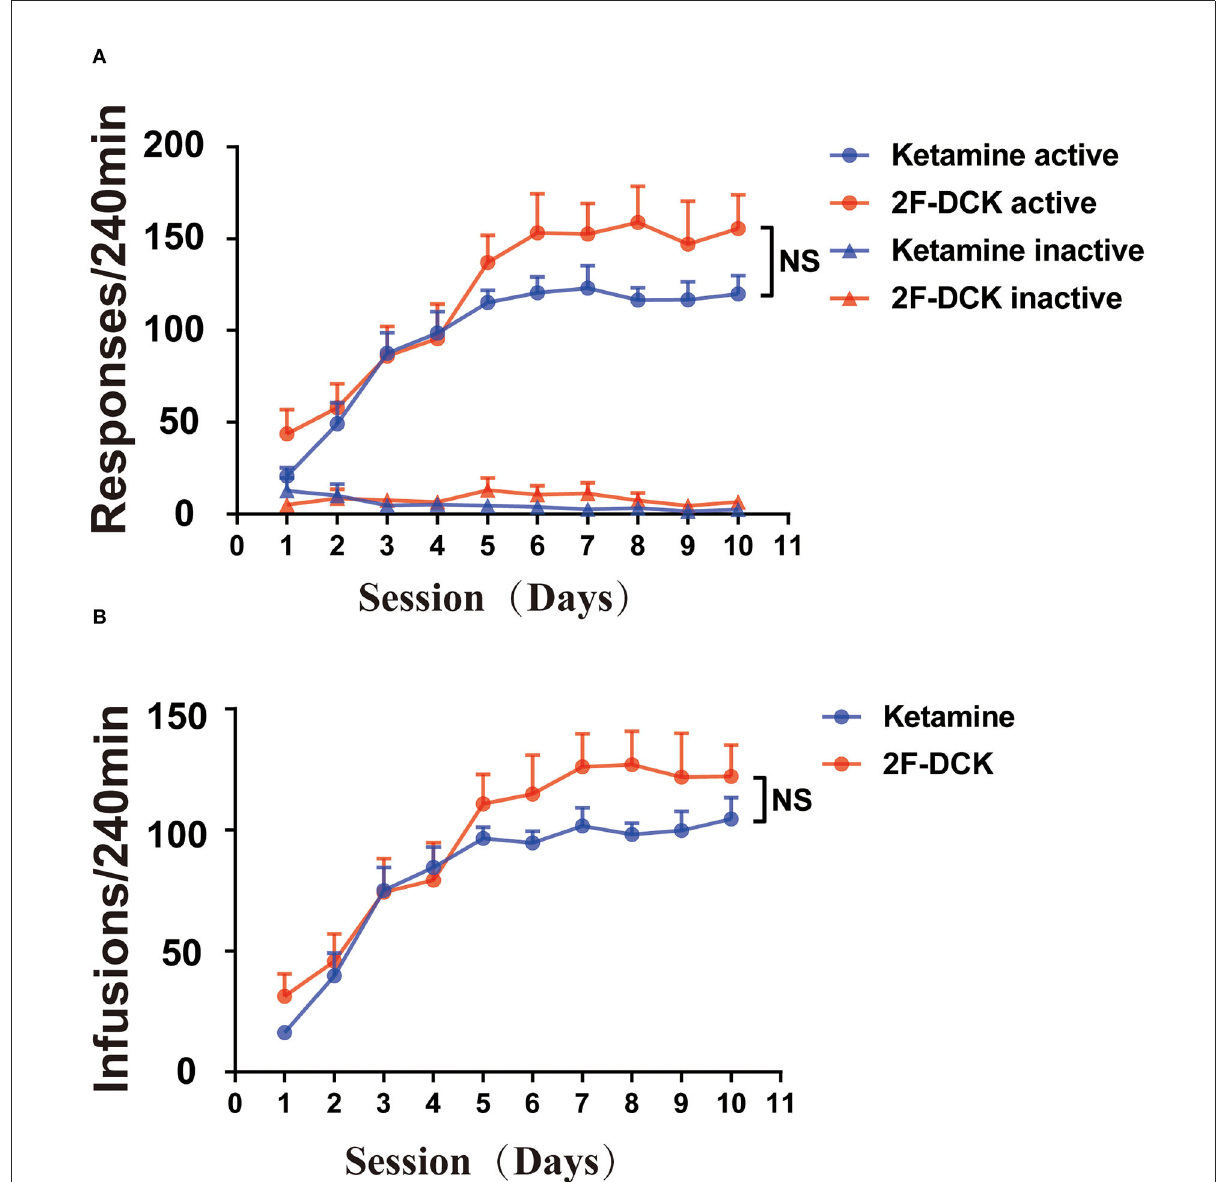
FIGURE1 2F-DCK and ketamine self-administration. The rats were acquired and maintained at stable 2F-DCK or ketamine self-administration for 10 days. (A) The active or inactive response per 4h of the training session was not different between 2F-DCK and ketamine groups under the FR1 schedule. (B) The total infusions per 4h trained for 10 sessions were also not different between 2F-DCK and ketamine groups. Data are presented as mean ± SEM. NS, not